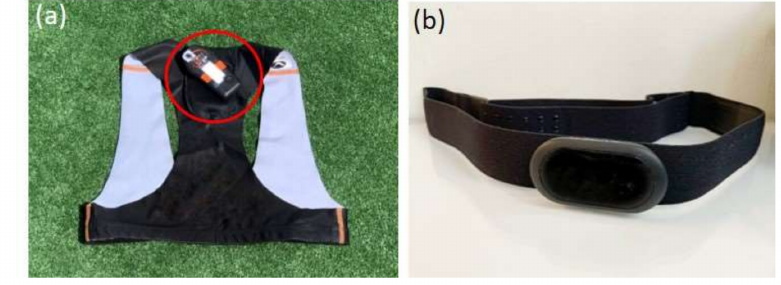
Figure 1. An example of ( a ) a global positioning system (GPS) unit (circled) with a vest, and ( b ) a heart rate monitor with chest